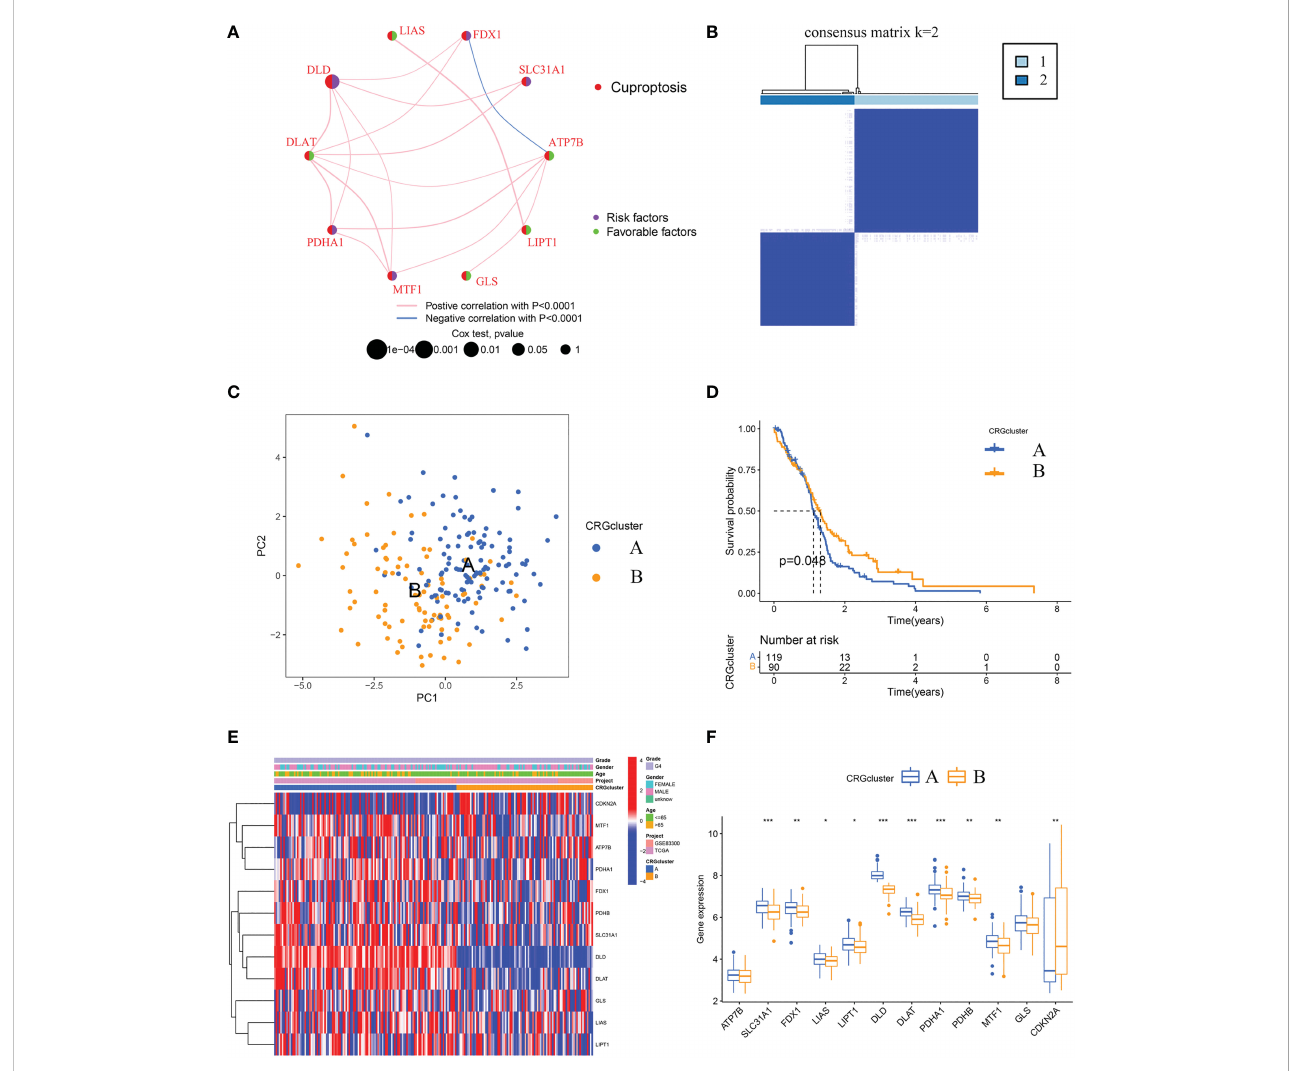
FIGURE 3 Identi fi cation of cuproptosis subtypes and comparison of clinical characteristics and CRGs expression levels between the two subtypes. (A) Interaction among CRGs in GBM. The line connecting the CRGs represents their interaction, with the line thickness indicating the strength of the association between CRGs. Pink lines and blue lines represent positive and negative correlations, respectively. (B) Unsupervised clustering analysis of prognostic CRGs. Consensus matrix heatmap de fi ning two clusters (k = 2) and their correlation area. (C) The PCA analysis based on the prognostic CRGs demonstrated that the patients in the different cuproptosis subtypes were distributed in two directions. Blue and yellow dots represent CRGcluster A and CRGcluster B. (D) Kaplan-Meier curves for OS of the two cuproptosis subtypes (chi-square test, p = 0.048). (E) The heat map shows the differences in clinical features and CRGs expression levels between CRGcluster A and CRGcluster (B, F) Box plot shows the differences of CRGs expression levels between CRGcluster A and CRGcluster B. CRGs, cuproptosis-related genes; GBM, glioblastoma; PCA, principal components analysis; OS, overall survival. * p < 0.05, ** p < 0.01, *** p < 0.001 vs. CRGcluster